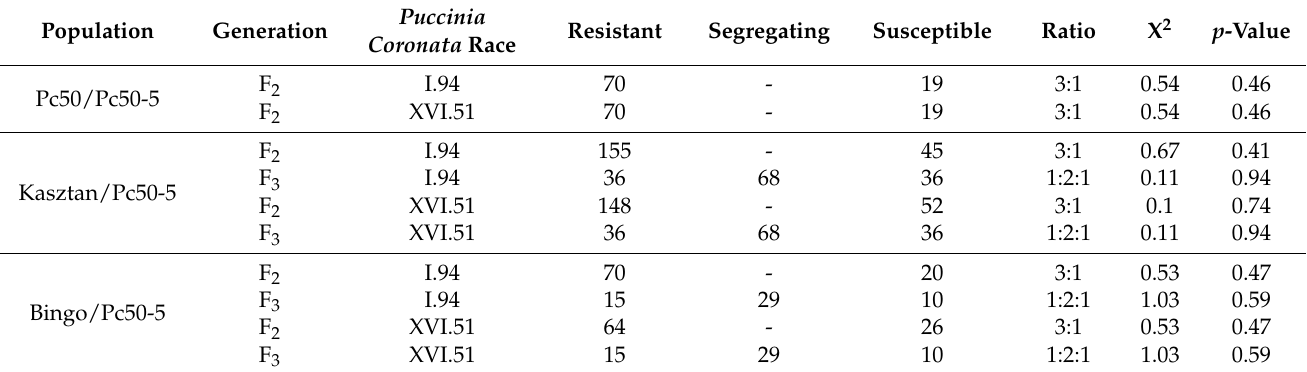
Table 2. Segregation ratios of F 2 progeny and F 3 families of populations Pc50/Pc50-5, Kasztan/Pc50-5 and Bingo/Pc50-5 when inoculated with P. coronata races I.94 and XVI.51.